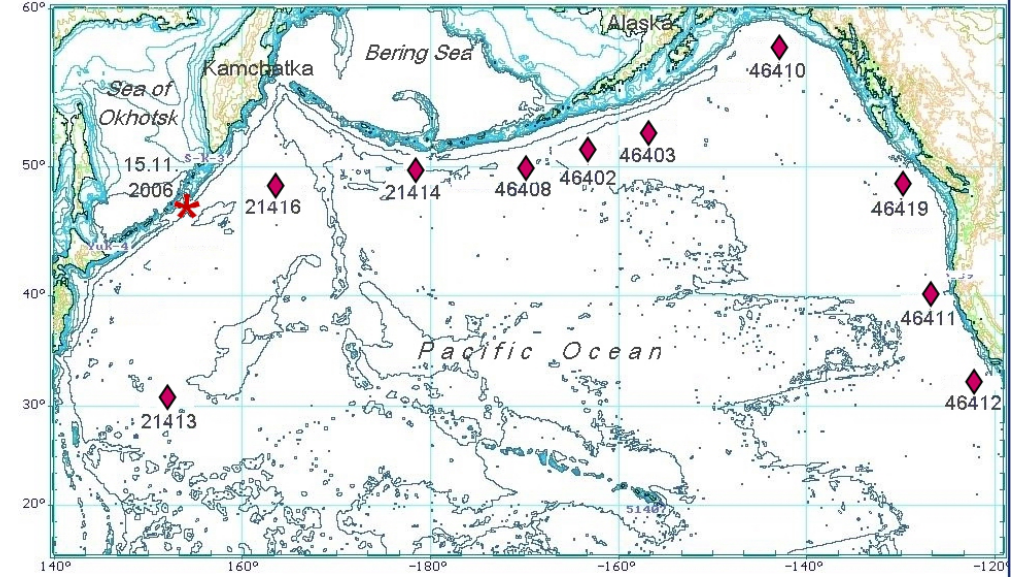
Fig. 4. A map of the North Pacific Ocean showing positions of DART stations and the epicenter of the 2006 Simushir earthquake. Epicenters of the 2007 and 2009 Simushir earthquakes are only slightly shifted from the location of the 2006